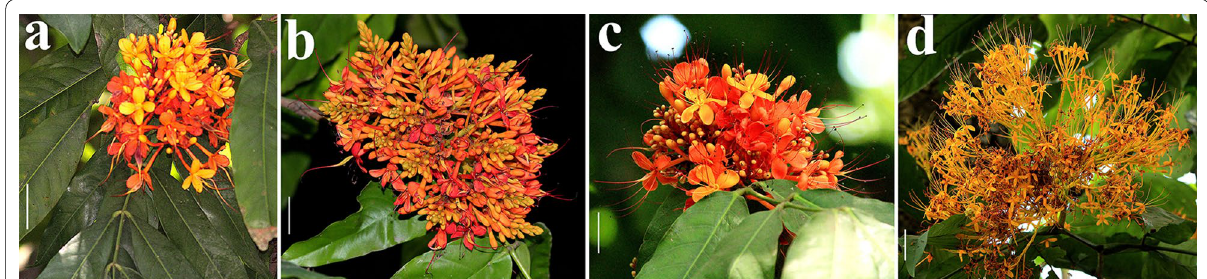
Fig. 1 Flowering twigs of four species of Saraca L. a S. asoca , b S. declinata , c S. indica and c S . thaipingensis (1 cm scale)